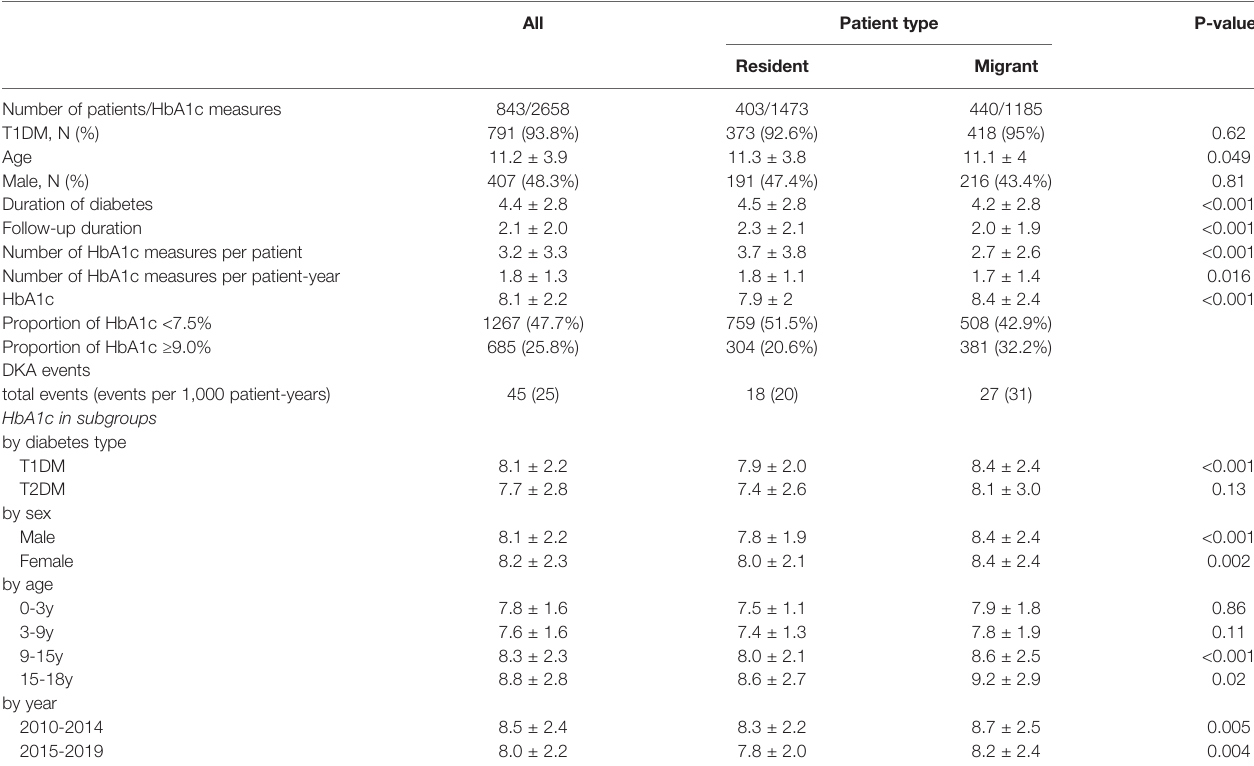
TABLE 1 | HbA1c in childhood DM patients in east